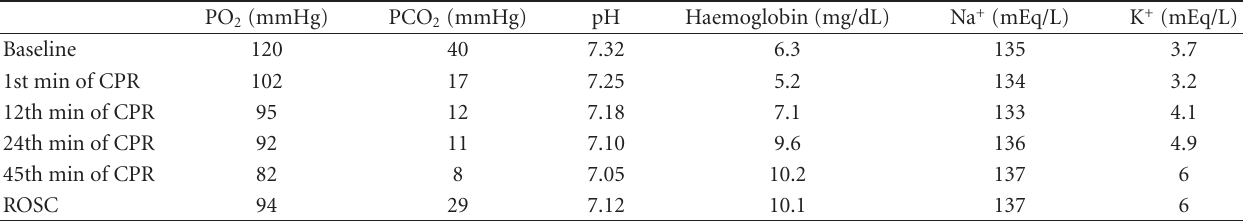
Table 1: Blood gases and electrolytes’ concentration at baseline, various phases of Cardiopulmonary Resuscitation and after Return of Spontaneous Circulation.